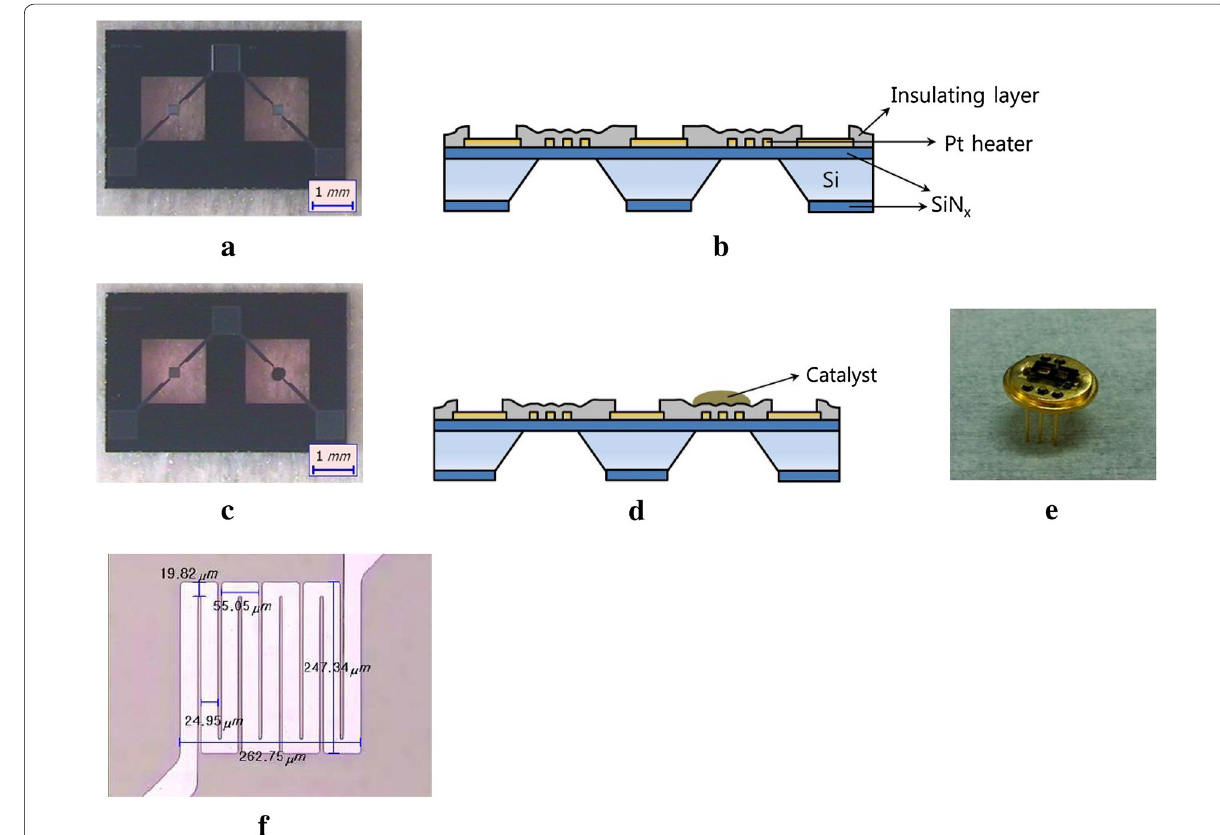
Fig. 1 Images of the catalytic combustible type single‑chip micro gas sensor platforms: top view of fabricated micro gas sensor platforms without catalyst materials ( a ) and with catalyst materials only on the right‑hand side membrane ( c ). b , d Schematic views of the cross‑section structures of a and c . e Image of single‑chip micro gas sensor platform c packaged on TO‑8. f Top image of fabricated Pt micro heater in single‑chip micro gas